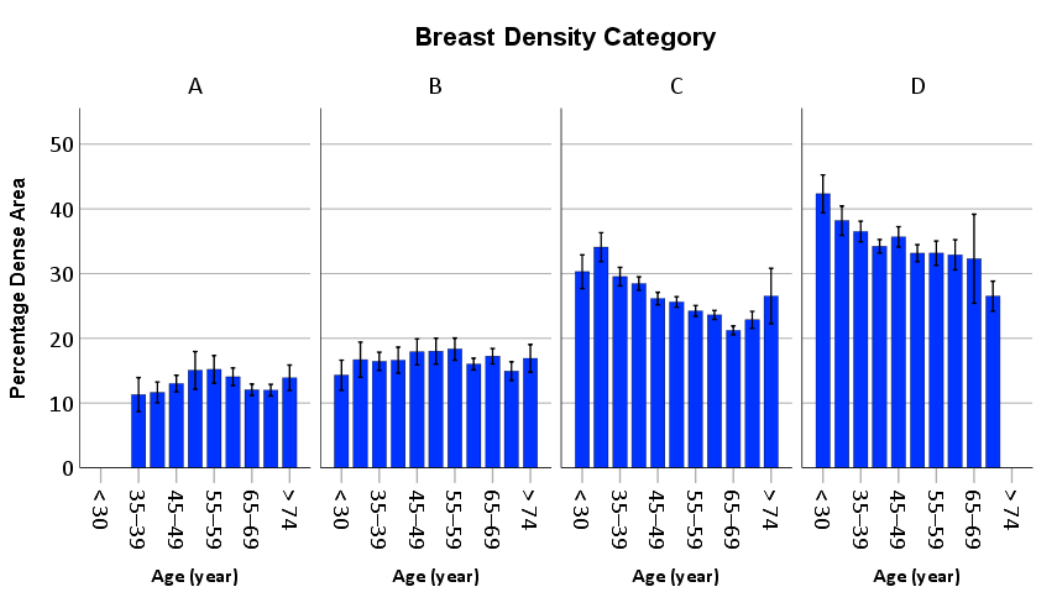
Figure 3. Mean percentage dense area of the breast according to age for the four breast density groups, measured according to using the 5th edition of the Breast Imaging Reporting and Data System (BI-RADS). Note: The error bars depicted the standard error of the mean. Category A, almost entirely fatty; category B, scattered areas of fibroglandular density; category C: heterogeneously dense; and category D: extremely